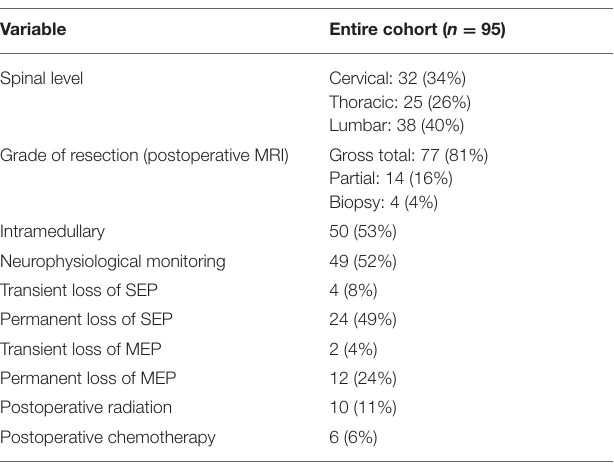
TABLE 2 | Intraoperative